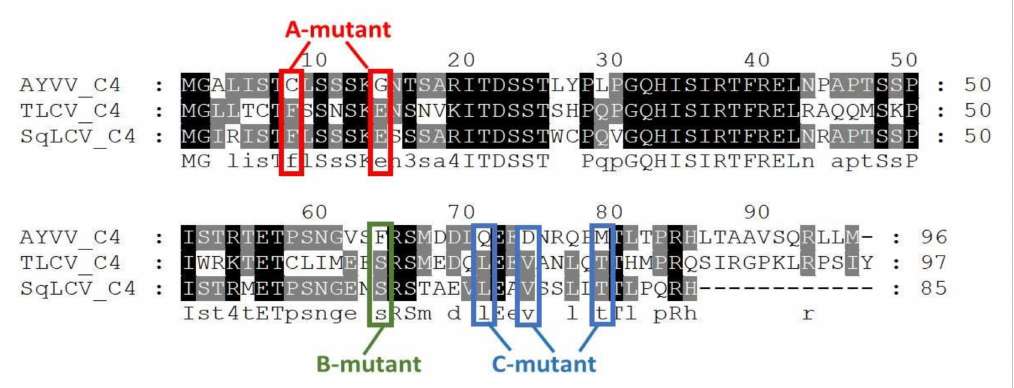
Figure 4. Alignment of C4 protein amino acid sequences of specific begomovirses. The amino acid sequences of C4 proteins encoded by begomoviruses inflicting leaf curl symptoms in opposite directions on N. benthamiana were aligned using the CLUSTAL W program [44] and represented using GeneDoc [45]. Among the begomoviruses shown, AYVV-NT caused severe upward leaf curling, whereas TLCV-TC and SqLCV-YL induced downward leaf curling. The amino acids selected to create mutants in subsequent analyses were boxed and indicated. The consensus sequence is shown at the bottom of the alignment. The degrees of conservation were indicated by the background color: black, 100% conservation; gray, conserved in two sequences; white, non-conserved.